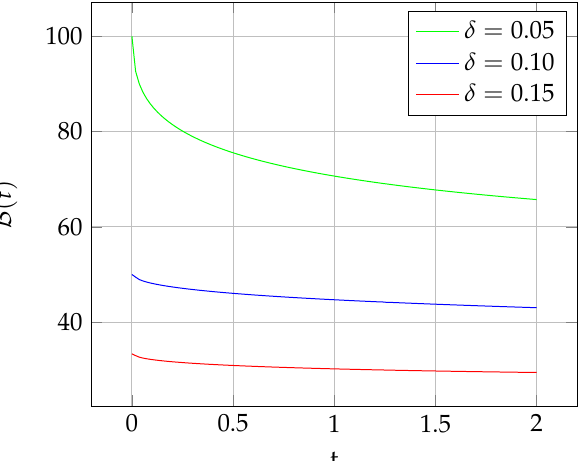
Figure 2. The numerical approximation of B ( t ) : K = 100, T = 2, r = 0.05, σ = 0.2 and δ = 0.05, 0.10,